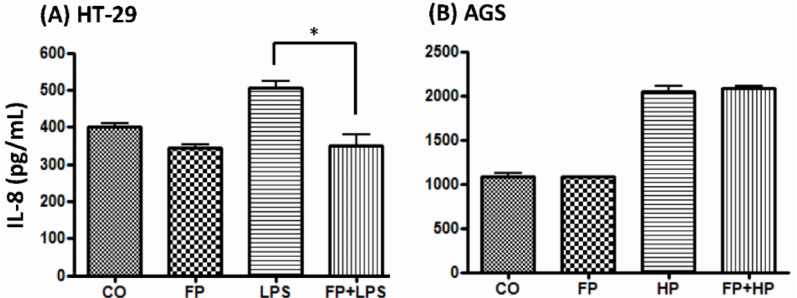
Figure 5. The e ff ects of pretreatment with F. prausnitzii supernatant on IL-8 levels in LPS-treated HT-29 cells ( A ) and H. pylori -treated AGS ( B ). The IL-8 levels were tested at 6 h. CO: control cells; FP: treatment with F. prausnitzii supernatant; HP: treatment with H. pylori ; LPS: treatment with LPS (10 µ g / mL); FP + LPS: pretreatment with F. prausnitzii supernatant and then LPS was added; FP + HP: pretreatment with F. prausnitzii supernatant and then H. pylori was added. * p <